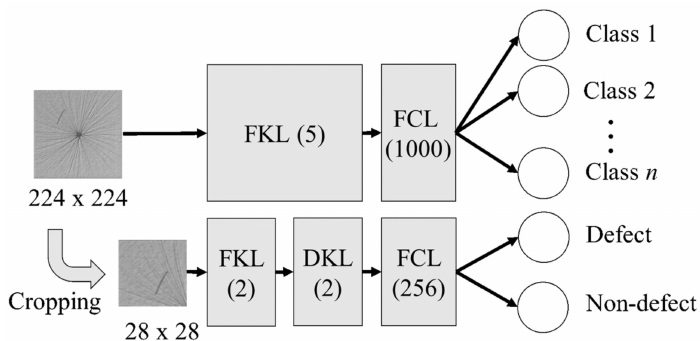
Figure 3. Schematic of the DF-ResNeXt